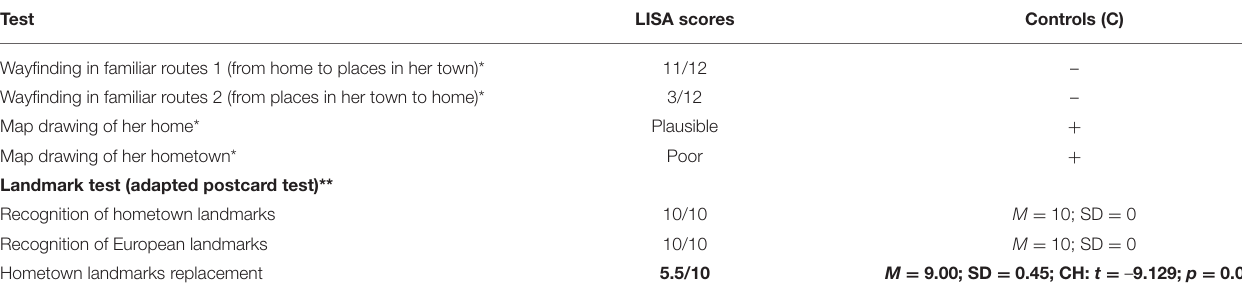
TABLE 2 | Results of LISA’s ecological spatial and navigational assessment. Test LISA